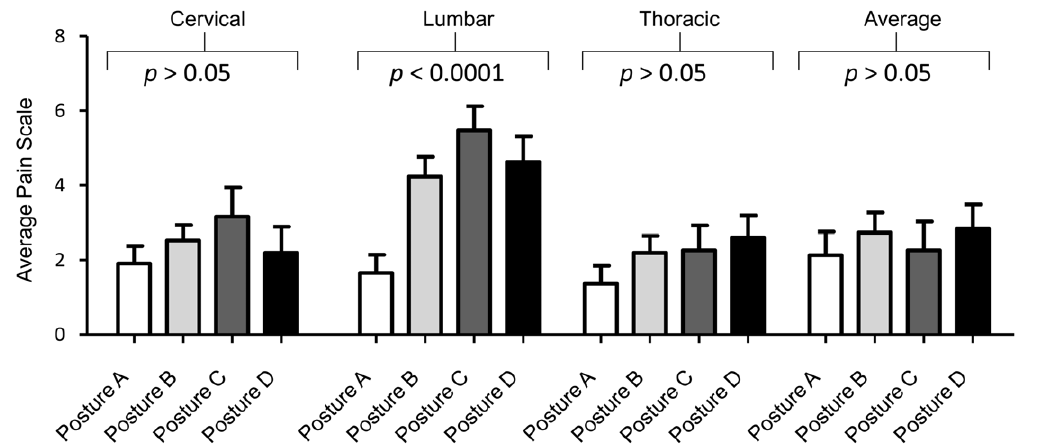
Figure 4. Subjects with ideal posture (A) reported the least amount of pain in the lumbar region. Subjects were asked to rate pain in the cervical, lumbar and thoracic regions on a scale of 0–10, with 10 signifying the most painful condition. There was no significant correlation between cervical and thoracic pain with posture. All other subjects, except for those in ideal posture, experienced more pain in all the observed areas. ( A, Ideal posture; B, Kyphosis-lordosis posture; C, Flat back posture; D, Sway-back posture ).